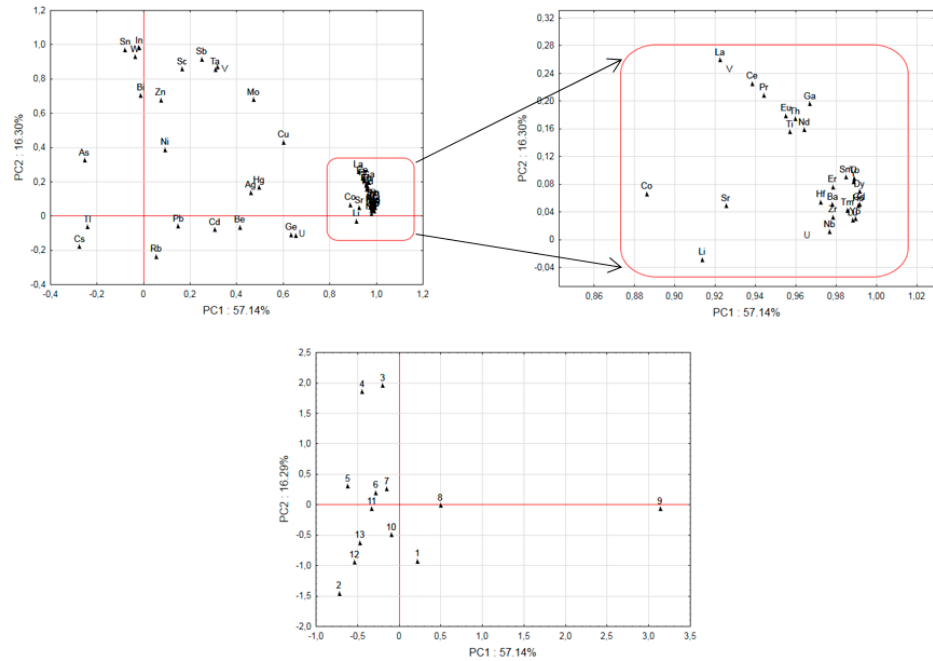
Figure 2. Plot of loadings based on the concentration of elements in fruiting bodies and projection of the element concentration levels in fruiting bodies collected in different sites set on the PC1 and PC2-plane, respectively (1. Coastal Landscape Park; 2. TLP, Osowa; 3. Augustów Primeval Forest; 4. Pomerania, Szczecinek; 5. Greater Poland, Pora ż yn; 6. WLP, Ko ś cierzyna; 7. Tuchola Pinewoods, Osiek; 8. Toru ń forests; 9. Mor ą g; 10. Olsztyn; 11., Pucha ł owo; 12. Piska Forest; 13. K ł odzka Dale).